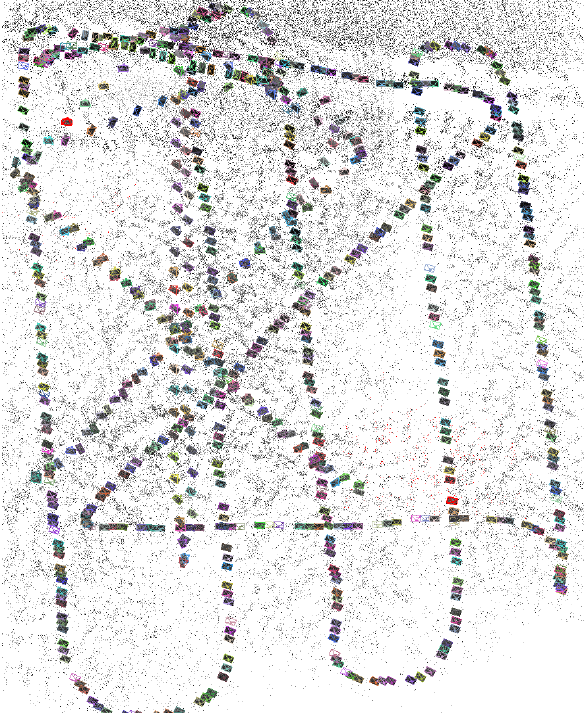
Figure 6. VisualSfM exterior orientation solution for combined oblique and nadir image block collected over forest. One channel from the data cube was used for oblique block and three channels for the nadir block.